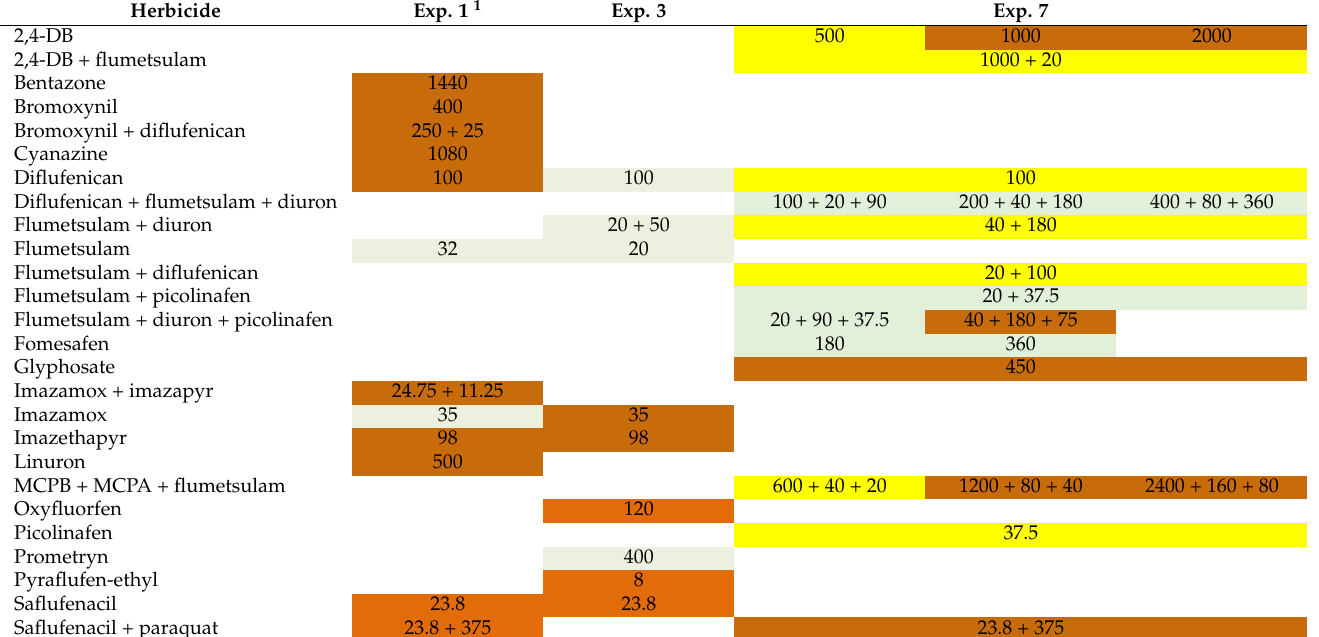
Table 17. Tolerance of adult Lanza ® tedera (one year old or older) to post-emergent herbicides to control broadleaf weeds. Herbicides/rates (a.i. g/ha) in green or yellow were not significantly different to an un-sprayed control, with those in green causing less than 10% biomass reduction and those in yellow causing more than 10% biomass reduction. Those in red had significantly less biomass than the un-sprayed